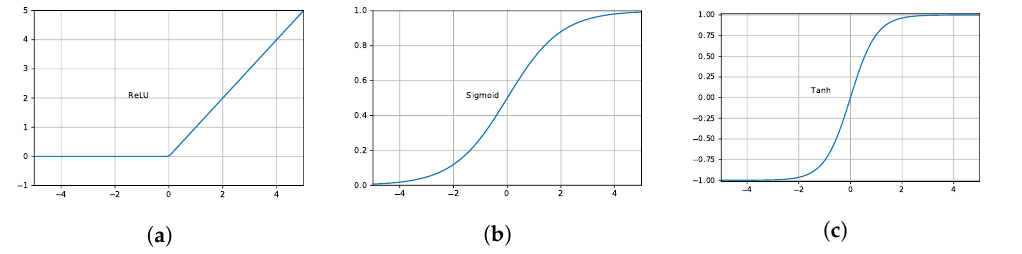
Figure 5. Curve representations of most used activation functions: ( a ) ReLU, ( b ) Sigmoid, and ( c ) Hyperbolic Tangent.